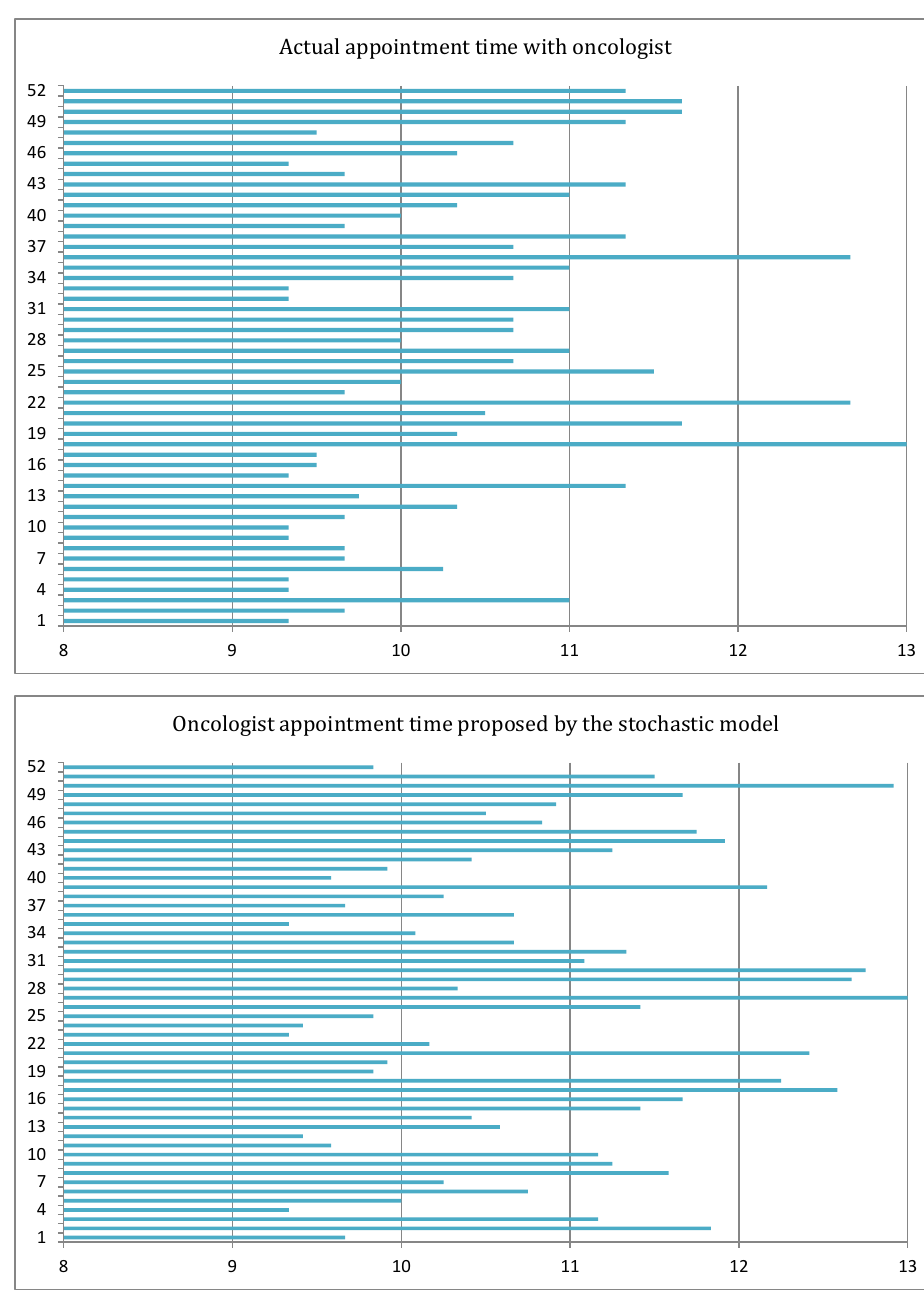
Figure 10. Actual oncologist appointment time and stochastic model proposed appointment time for patients on Monday 11 January 2021. X-axis: time of day between 8:00 and 13:00 h. Y-axis: patient